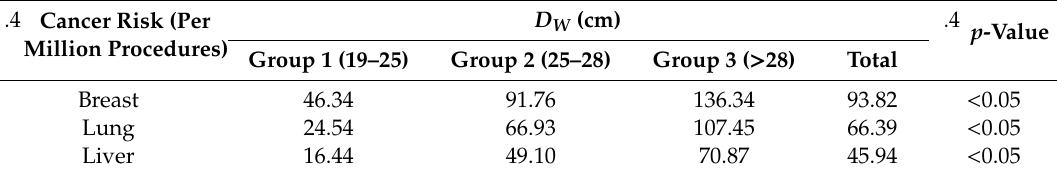
Table 4. Mean cancer risk estimation according to group study per one million procedures.